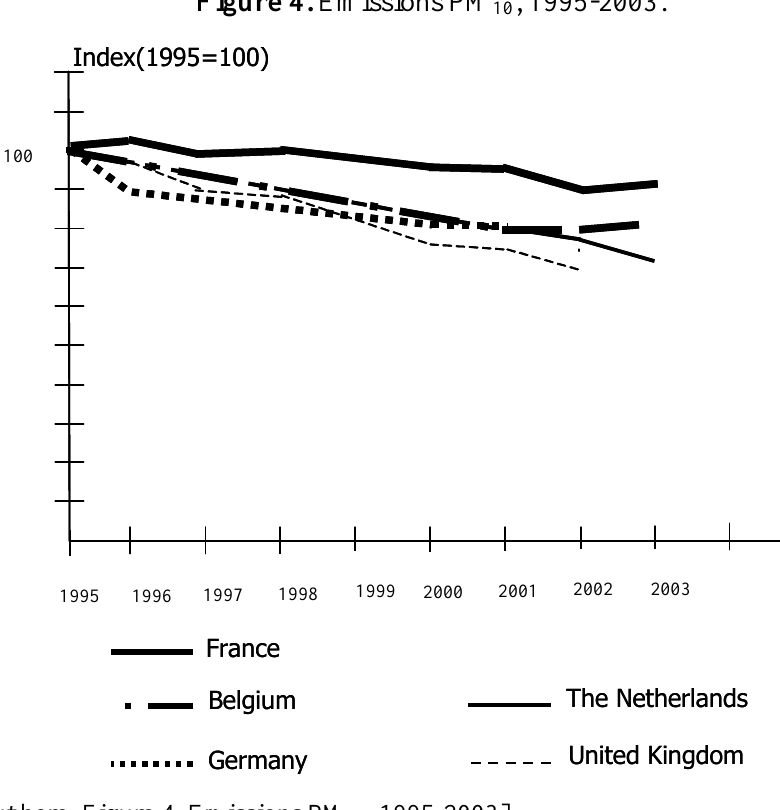
Figure 4. Emissions PM